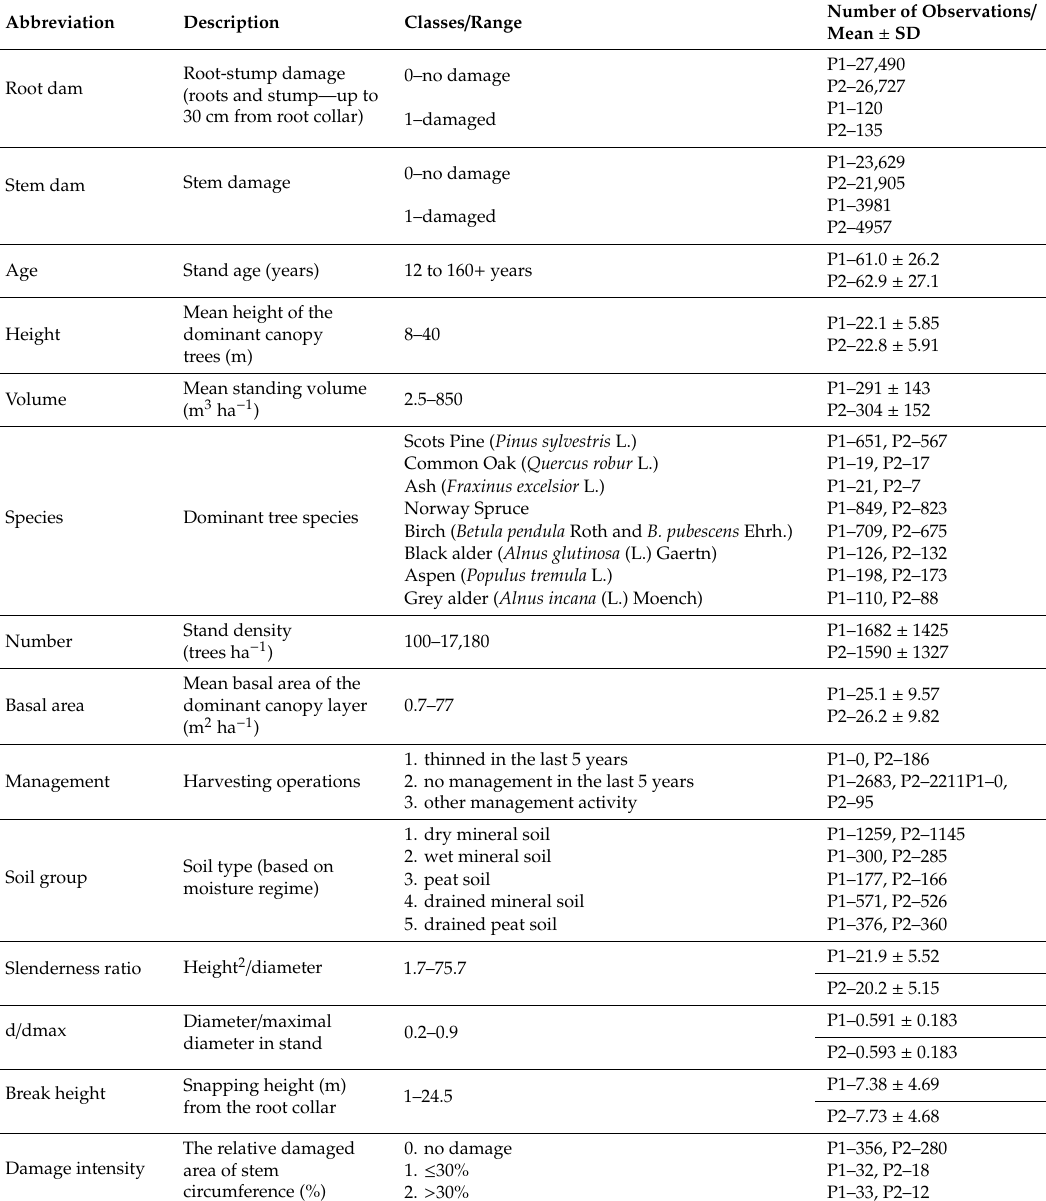
Table 1. Description of explanatory variables tested in the models. Number of observations for categorical variables; mean ± standard deviation (SD) for continuous variables. P1—the first period; P2—the second